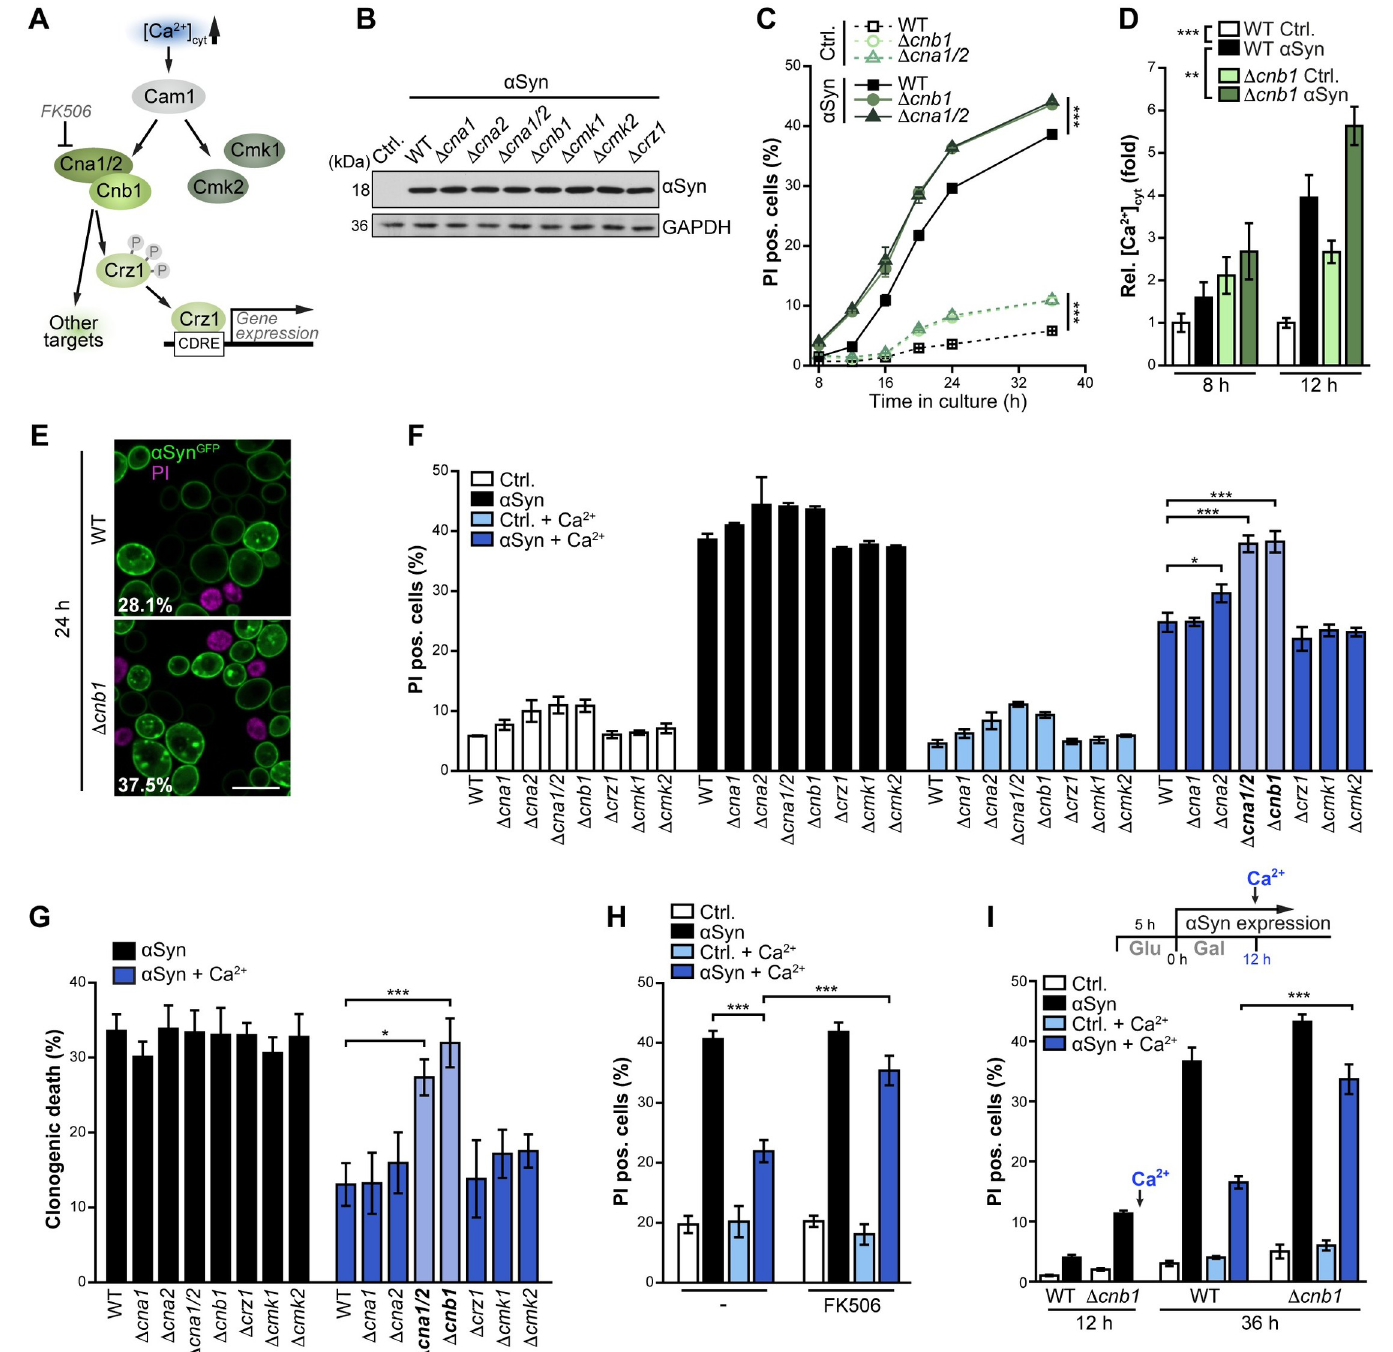
Fig 3. Cytoprotection achieved by Ca 2+ administration requires functional calcineurin signaling. ( A ) Schematic of the main Ca 2+ signaling pathway in yeast. Cytosolic Ca 2+ binds to Calmodulin, which activates the Ca 2+ /calmodulin-dependent protein kinases Cmk1 and Cmk2 and protein phosphatase calcineurin. Calcineurin consists of a regulatory (Cnb1) and one of two catalytic subunits (Cna1 or Cna2) and dephosphorylates numerous cellular targets, among them the calcineurin-responsive zinc finger transcription factor Crz1, which in response translocates into the nucleus to adapt gene expression. Calcineurin can be inhibited by the immunosuppressant drug FK506. ( B ) Immunoblot analysis of protein extracts from WT cells and indicated deletion mutants after 24 h of α Syn expression. Blots were probed with antibodies directed against FLAG-epitope to detect FLAG-tagged α Syn and against glyceraldehyde 3-phosphate dehydrogenase (GAPDH) as a loading control. ( C ) Cell death determined by propidium iodide (PI) staining of WT cells and calcineurin deletion mutants expressing α Syn or harboring the vector control (Ctrl.). Means ± s.e.m; n = 4. ( D ) Aequorin luminescence-based determination of basal cytosolic Ca 2+ levels in WT and Δ cnb1 cells expressing α Syn for 8 h and 12 h. Data were normalized to WT vector control. Means ± s.e.m; n = 12. ( E ) Confocal micrograph of WT and Δ cnb1 cells expressing α Syn GFP for 24 h. Cells have been counterstained with PI to visualize dead cells. Scale